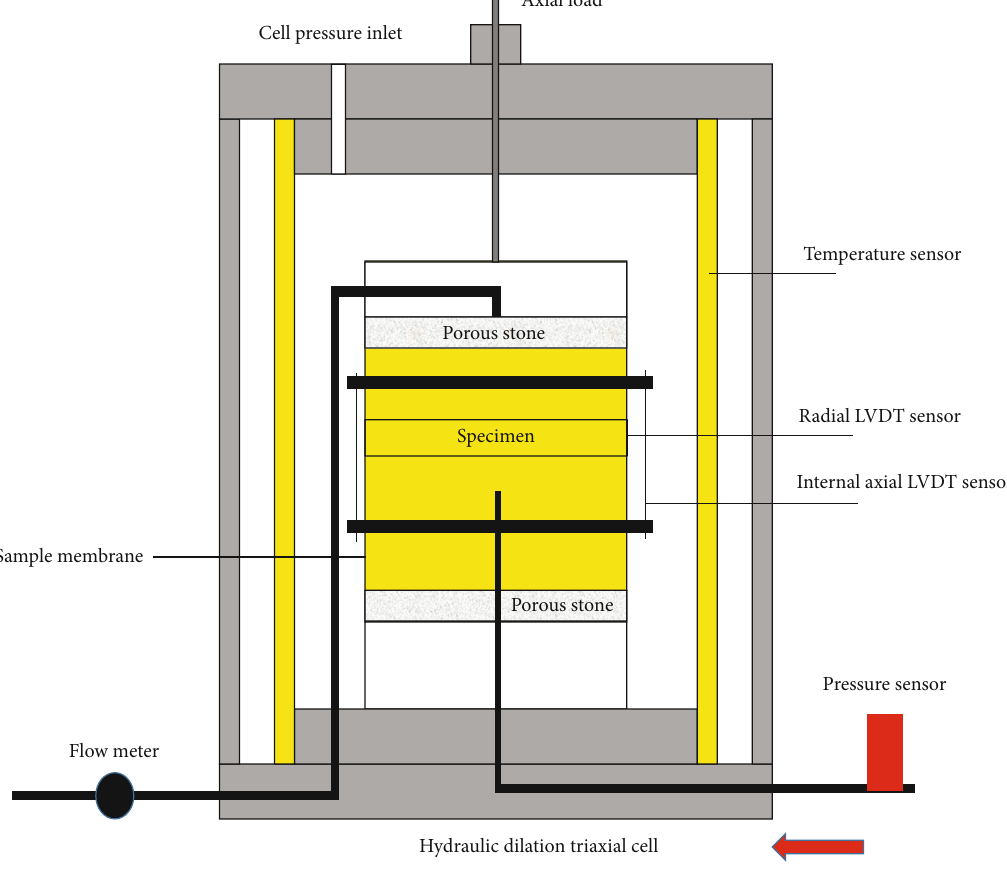
Figure 4: Hydraulic dilation txiaxial